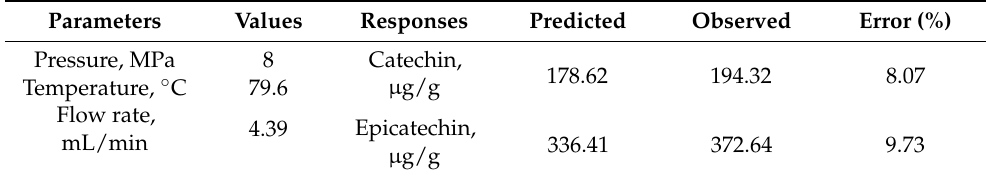
Table 4. The predicted and observed parameters and responses for SME.